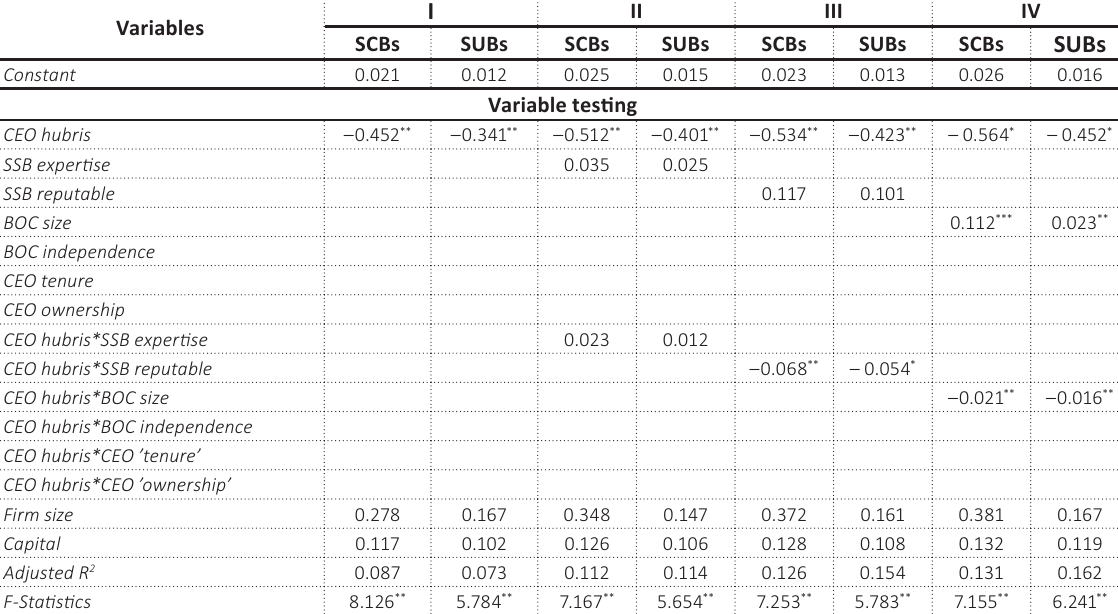
Table 5. GLS regression with the random impacts analysis for SCBs and SUBs